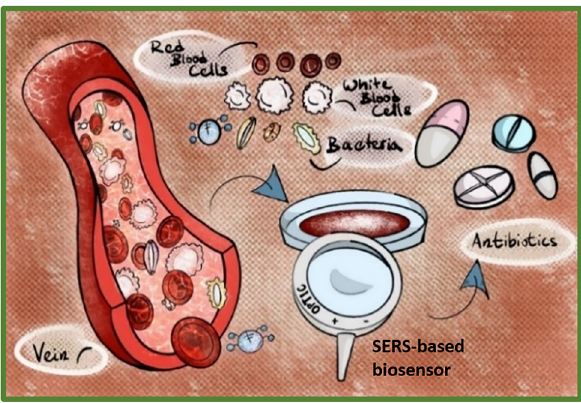
Figure 1: In order to determine bacterial pathogens in a small amountofbloodistakenfromaveinwithaneedle.Consequently,in an ideal case, pathogens are identified quickly and appropriate antibiotics are prescribed. Here is shown surface enhanced Raman scattering (SERS) as a potential method of choice which excels in speed and sensitivity. Figure courtesy of Gabriela